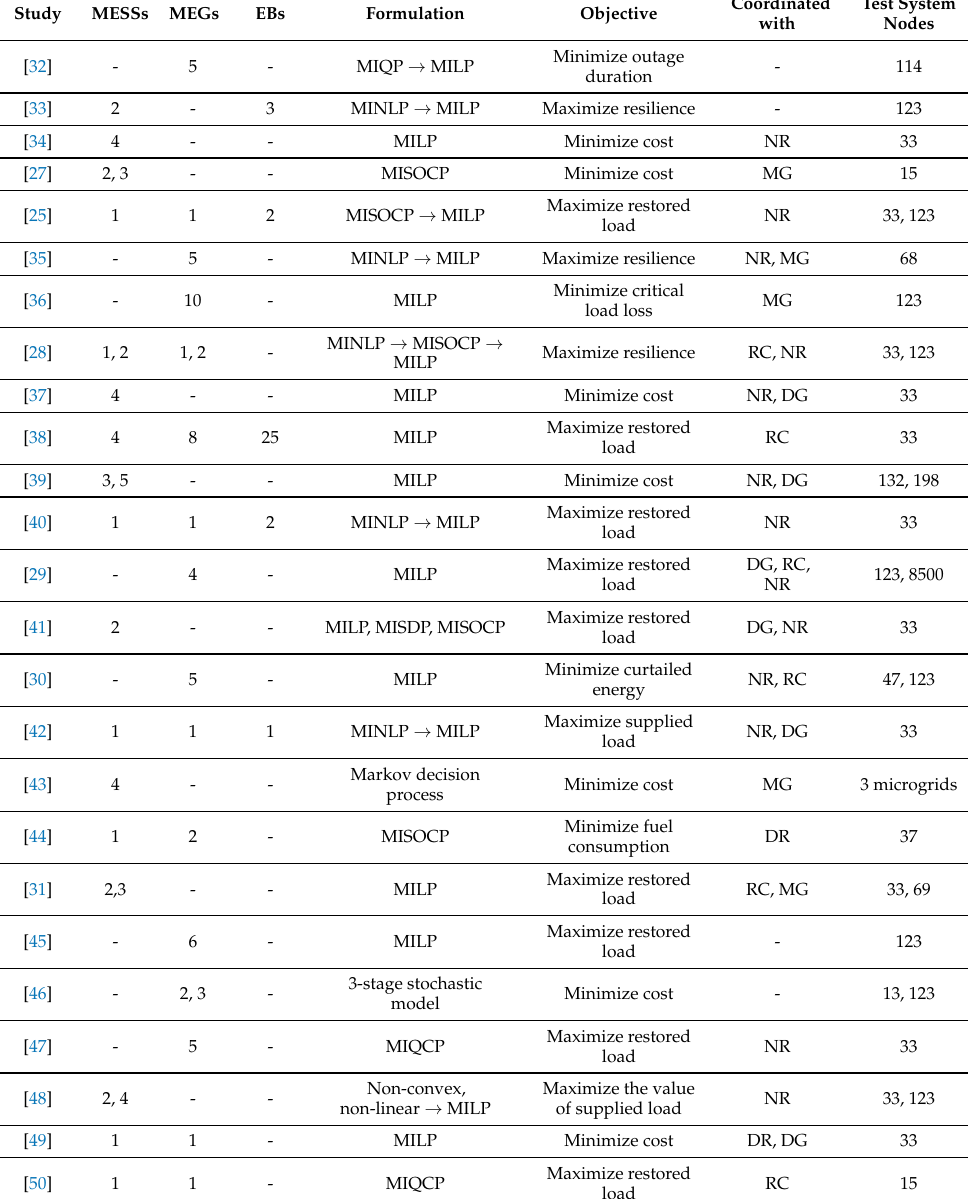
Table 1. Survey of previous work on the use of mobile energy resources for resilience enhancement. The arrows indicate that the original formulation is transformed to a more simplified version for better tractability and convergence. The following abbreviations are used: MIQP = mixed integer quadratic program, MILP = mixed integer linear program, MINLP = mixed integer nonlinear pro- gram, MISOCP = mixed integer second order cone program, MIQCP = mixed integer quadratically constrained program, MISDP = mixed integer semidefinite